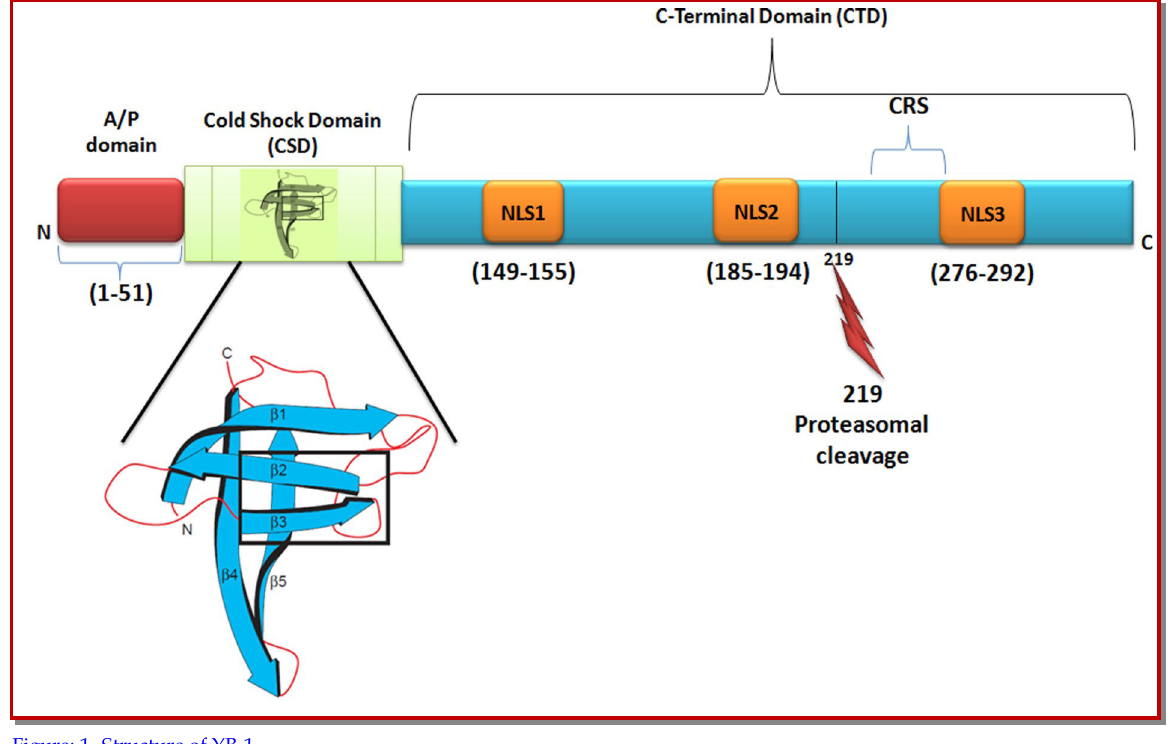
Figure: 1 Structure of YB-1 The structure of YB-1 might be subdivided in to three domains such as N-terminal domain, cold shock domain and C-terminal domain. The central part of the YB-1 is cold shock domain (52-129 residues) comprises of ~70 amino acids. As is evident by NMR structural studies of cold shock domain, the cold shock domain forms backbone of the protein and consists of five (cid:451) - strands arranged as anti-parallel (cid:451) barrel connected with three tight type -I turn ( (cid:451)1 - (cid:451)2, (cid:451)2 - (cid:451)3 and (cid:451)4 - (cid:451)5) and flexible loop ( (cid:451)3 - (cid:451)4). (cid:451)2 - (cid:451)3 has a fixed orientation while (cid:451)1 - (cid:451)2 and (cid:451)4 - (cid:451)5 can adopt different orientations. At the end, long C-terminal domain (130-324) contains positive and negative charged clusters. Each cluster is nearly 25-30 amino acids long and present alternatively (Kloks et al.,